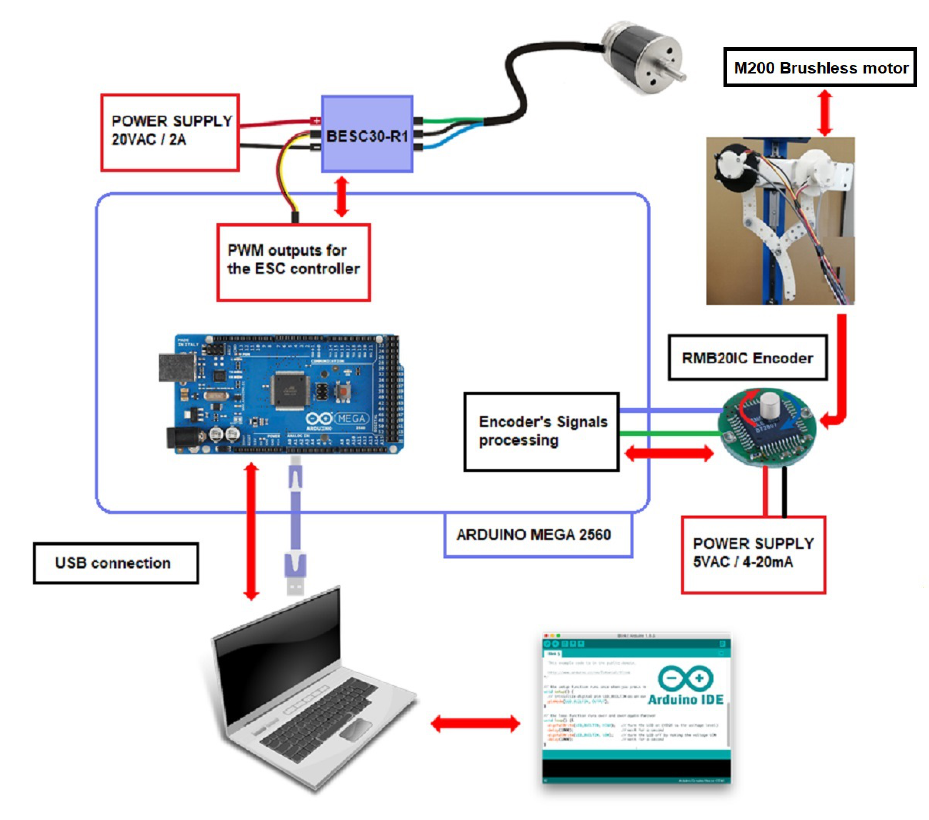
Figure 12. Hardware and software architecture for angular position